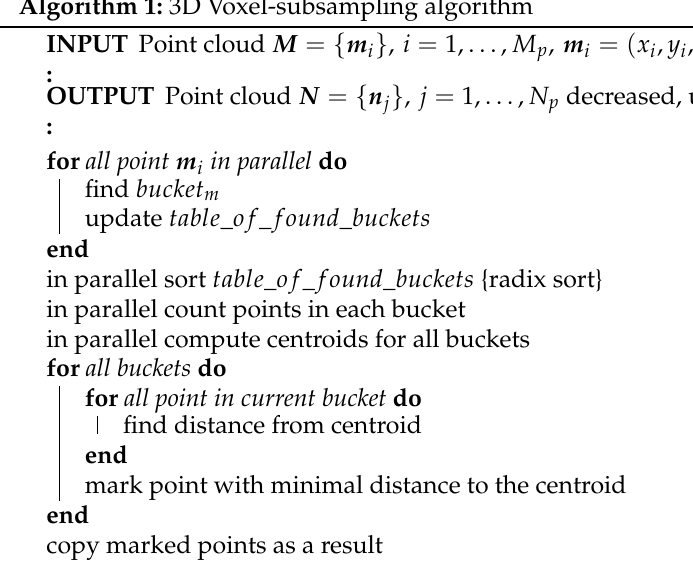
Algorithm 1: 3D Voxel-subsampling